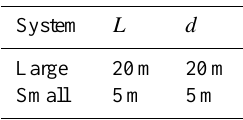
Table 1. Dimensions of the two standard